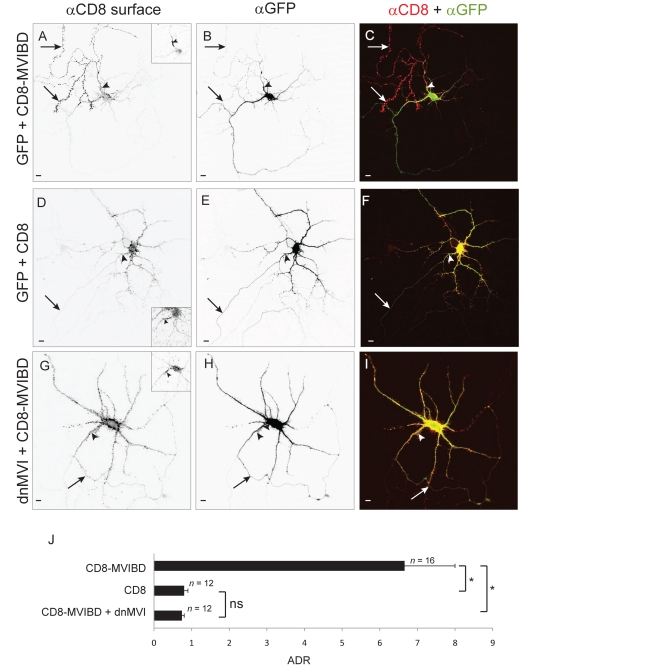
Interaction with Myosin VI is sufficient to enrich a heterologous protein at the surface of the axon.In a cortical neuron in dissociated culture, surface-labeled CD8 fused to MVIBD (CD8-MVIBD) (A) is highly enriched at the surface of the axon, in contrast to the nonspecific localization of coexpressed GFP (B). (C) Merge of CD8-MVIBD (red) and GFP (green). In contrast, when CD8 (D) is coexpressed with GFP (E), it localizes nonspecifically. (F) Merge of CD8 (red) and GFP (green) showing that the two proteins colocalize. When CD8-MVIBD (G) is coexpressed with GFP-dnMVI (H), it localizes nonspecifically. (I) Merge of CD8-MVIBD (red) and GFP-dnMVI (green) indicates that the two proteins colocalize. (J) The average ADR of CD8-MVIBD is greater than 6-fold higher than that of CD8 when coexpressed with GFP or of CD8-MVIBD when coexpressed with dnMVI. *, p<0.0001; ns, p>0.5, Wilcoxon-Mann-Whitney test. Insets show staining of endogenous Ankyrin G. Arrows point to the axon; arrowheads point to the axon initial segment. Scale bars are 10 µm.